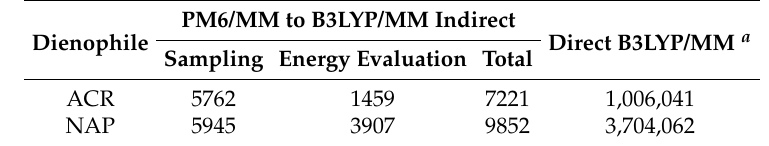
Table 4. Estimated wall-clock time in a unit of hours for the computations of the QM/MM free energy surfaces at the B3LYP/6-31G(d) level. Assuming one node with 16 cores of Intel Xeon CPU E5-2660 2.20 GHz was